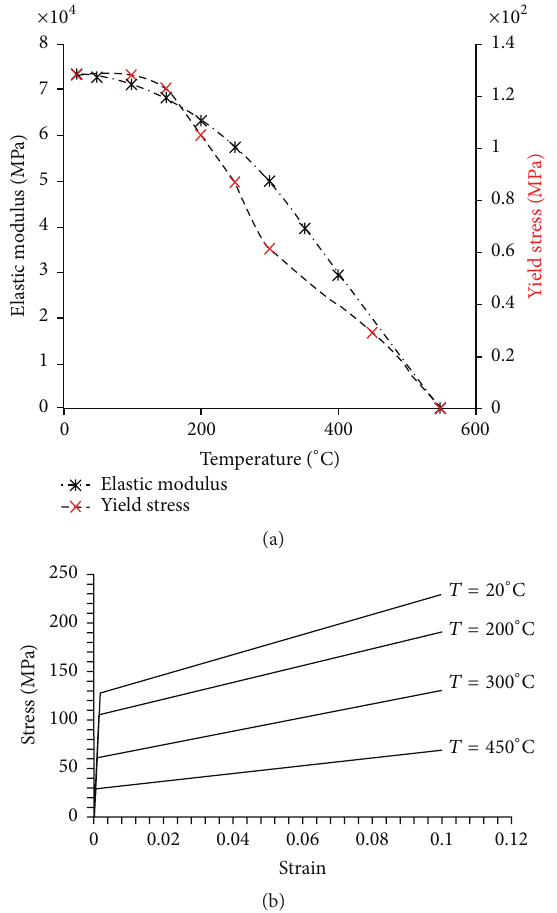
Figure 11: Mechanical characteristics versus temperature (a); stress- strain relation at different temperatures